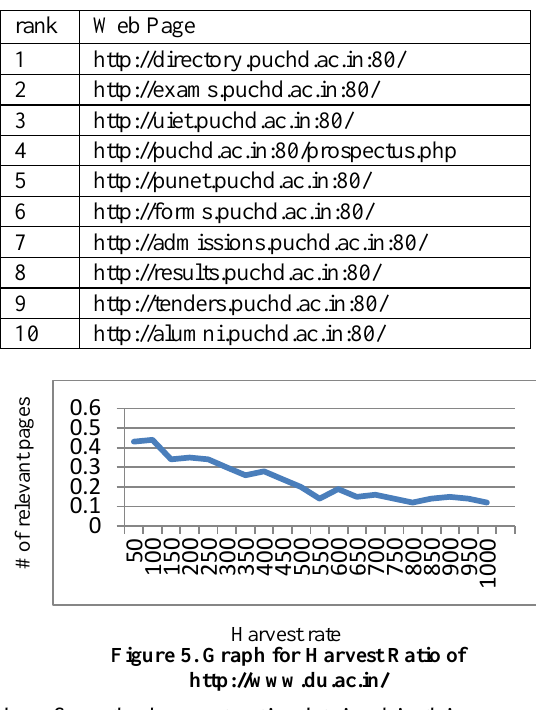
Table 1. Top 10 results for Panjab University